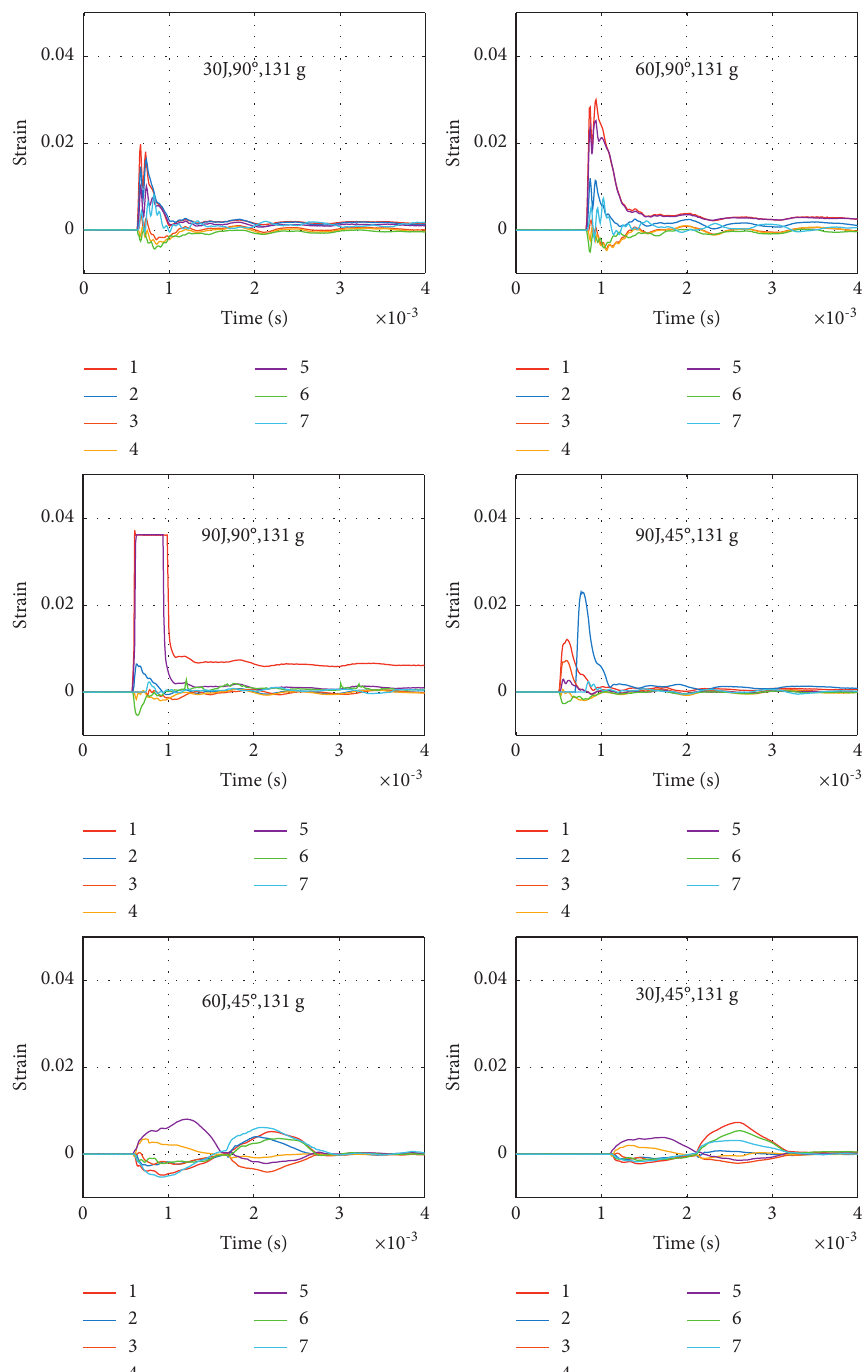
Figure 6: Strain changed at the back of the oil sump body under the impact of a 131g